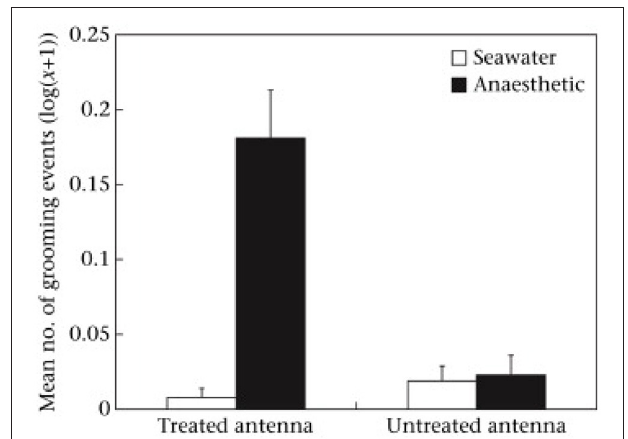
FIGURE 1 | Mean ± SE [log( x + 1)] of grooming of treated and untreated antennae following application of seawater or anesthetic in the first observation. Reproduced with permission from Barr et al.